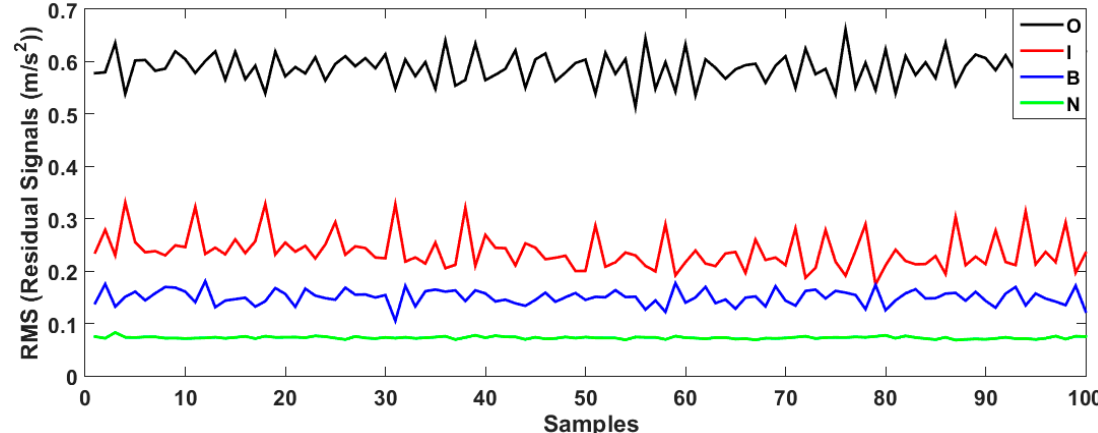
Figure 11. Bearing’s RMS residual signals using the proposed FVSF method.